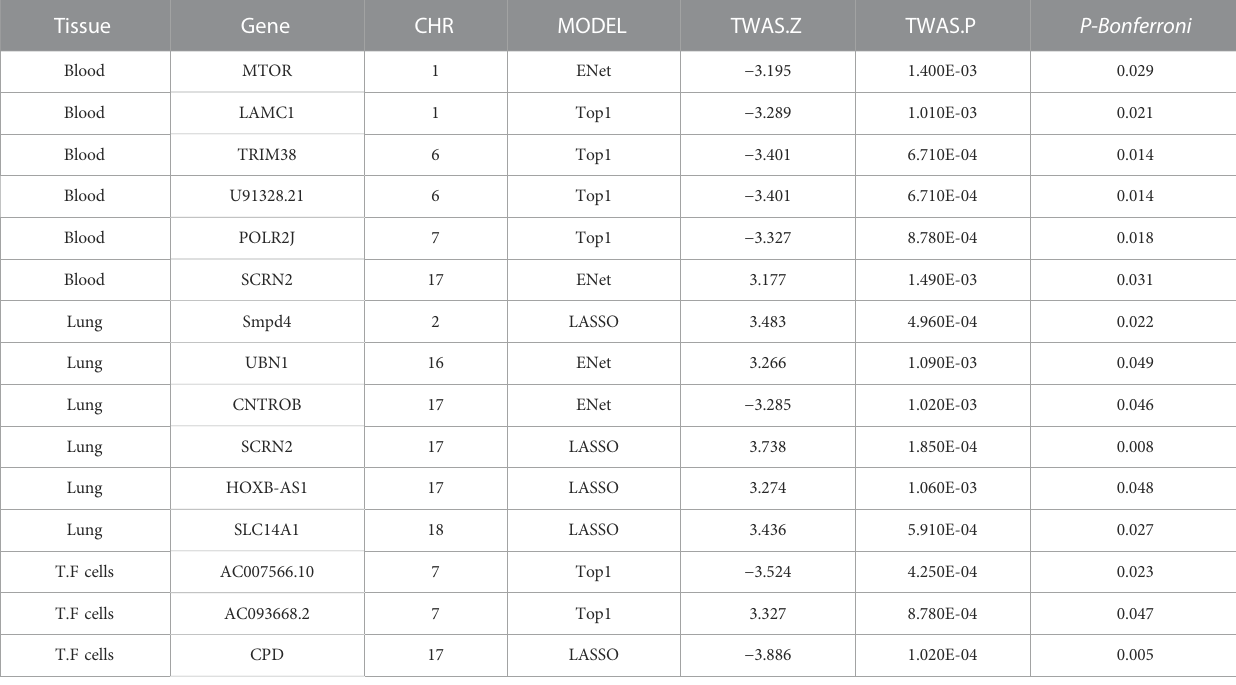
TABLE 3 Genes signi fi cantly associated with the risk of mumps. Tissue